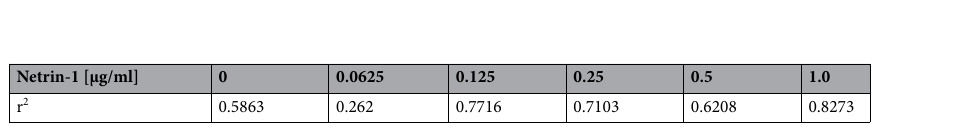
Table 2. The coefficient of determination (r 2 ) for the BMP4 response (pSmad1/5 level) against the LRIG3- FLAG expression levels at different netrin-1 concentrations as shown in Fig.